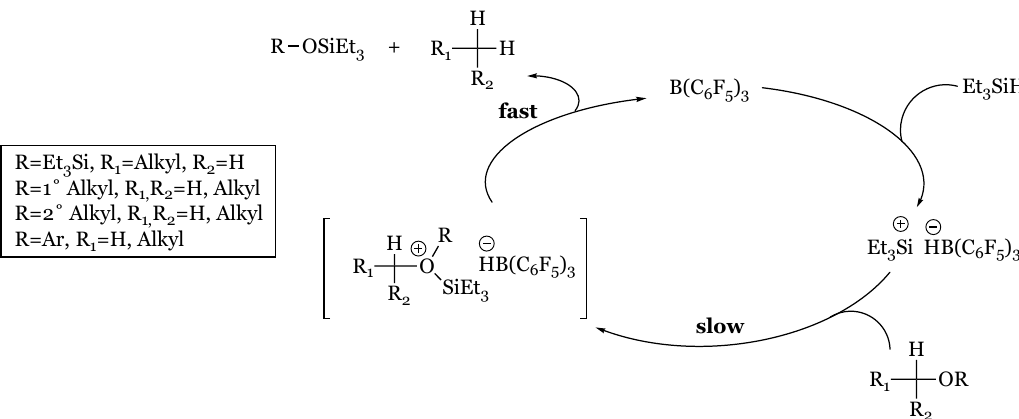
Figure 47. Exhaustive reduction of silyl ether generated by initial dehydro-condensation to hydrocarbon.